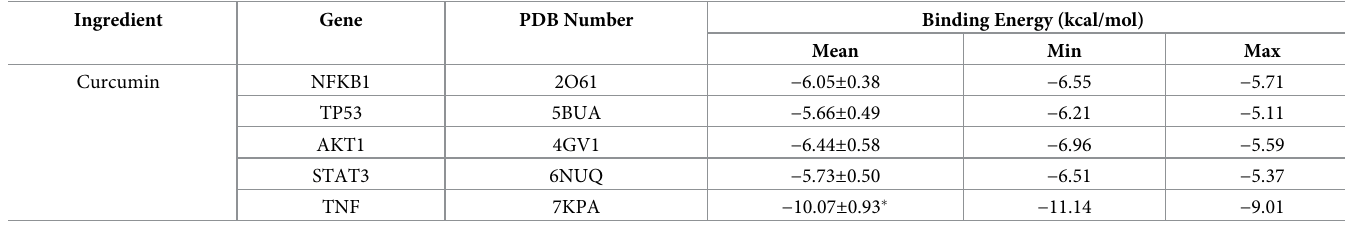
Table 2. Docking results of curcumin with key target molecules. Ingredient Gene PDB Number Binding Energy (kcal/mol)